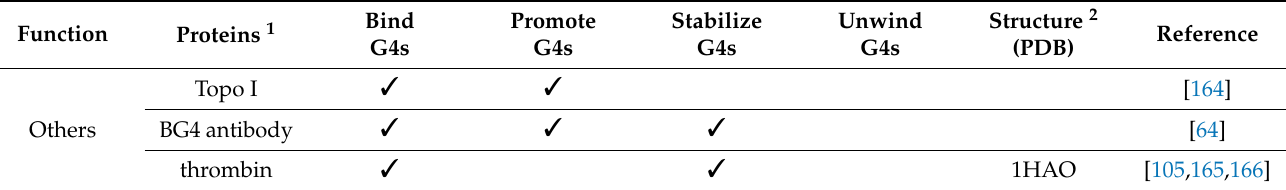
Table 1. Cont. Table 1. Representative G4-interacting proteins. Table 1. Representative G4-interacting proteins. Table 1. Representative G4-interacting proteins. Table 1. Representative G4-interacting proteins. Table 1. Representative G4-interacting proteins. Table 1. Representative G4-interacting proteins. Table 1. Representative G4-interacting